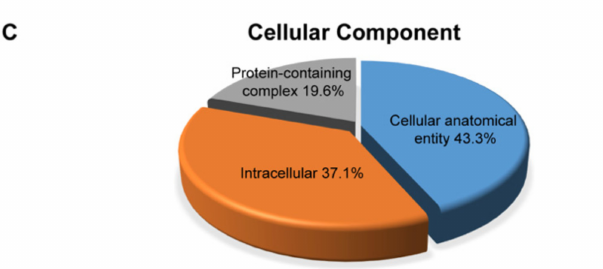
Figure 3. Pie charts showing the proteome distribution. All DEPs were annotated with the PANTHER Classification system (http://www.pantherdb.org/, accessed on 2 November 2021) according to their molecular function ( A ), biological process ( B ), and cellular component ( C ).